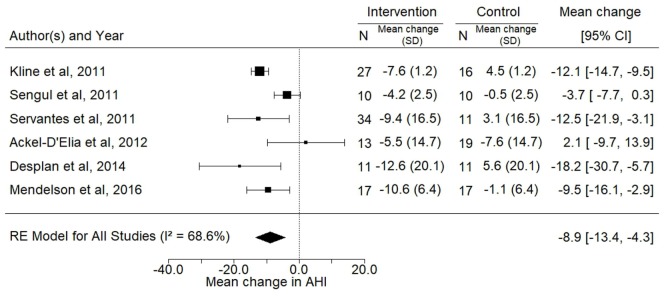
Forest plot for the mean change in apnea–hypopnea index (AHI) (events/h) following exercise training. The diamond reflects the 95% confidence interval of the pooled estimate of mean difference. Ref (16, 22, 30–33).